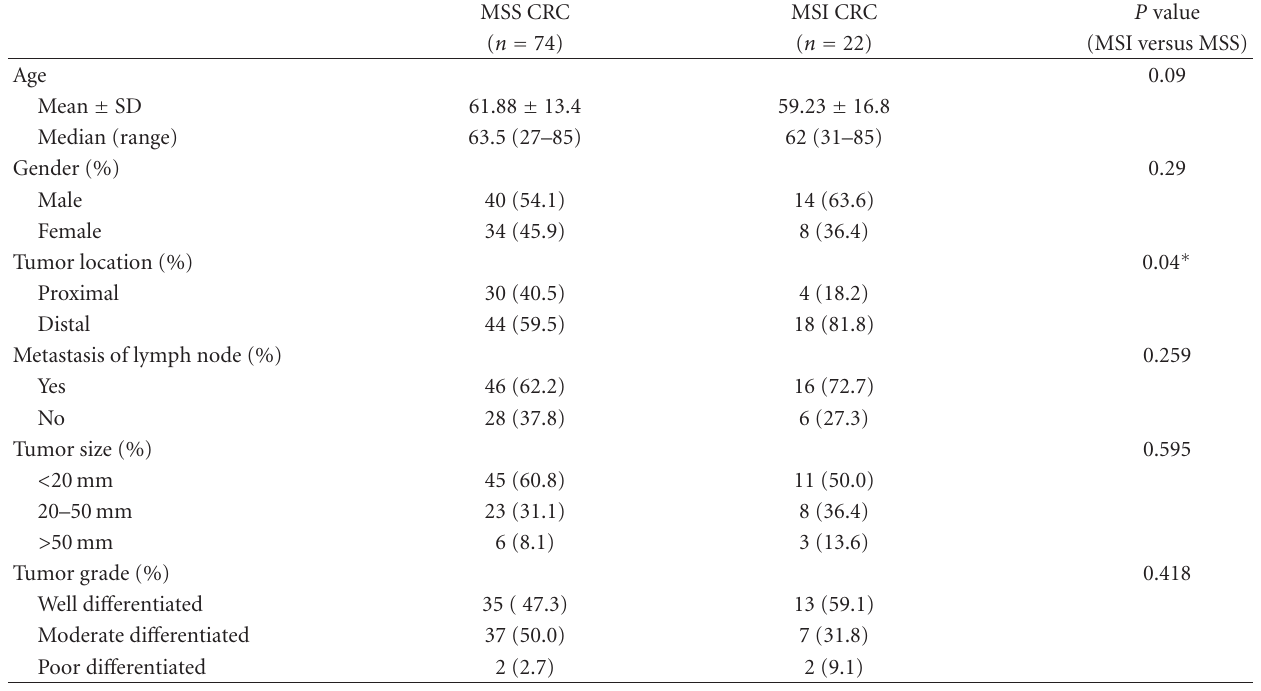
Table 1: Clinicopathological features of colorectal cancers patients according to microsatellite instability status.